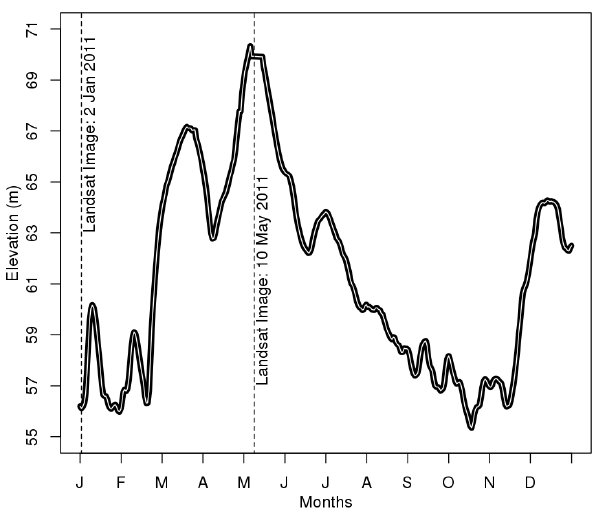
Fig. 3. Year 2011 water height profile for Mississippi River at Figure 3: Year 2011 water height profile for Mississippi River at Memphis, Memphis, TN.